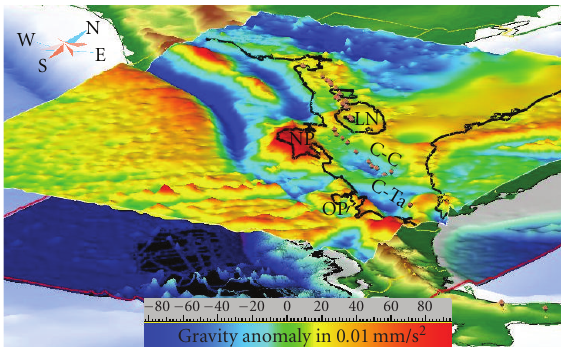
Figure 9: The Bouguer anomaly onshore is portrayed together with Free-Air anomaly (o ff shore) in the area of Costa Rica and Nicaragua looking from southeast. Most prominent features are the positive anomaly on Nicoya Peninsula (NP), which is caused by the high density ophiolite complex and gravity lows in the basin west of the Talamanca area. The gravity anomaly is pictured in exact the same area of the high resolution topography, as presented before in Figure 5. For more details refer to the text.